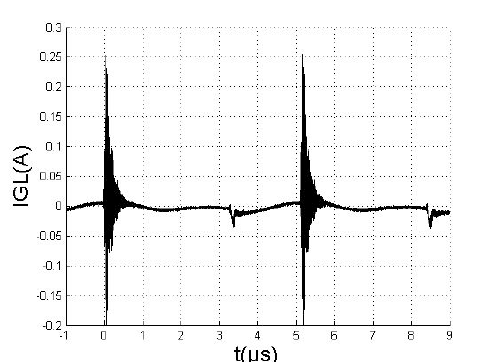
Figure 27: Experimental waveform of the current i . G-in